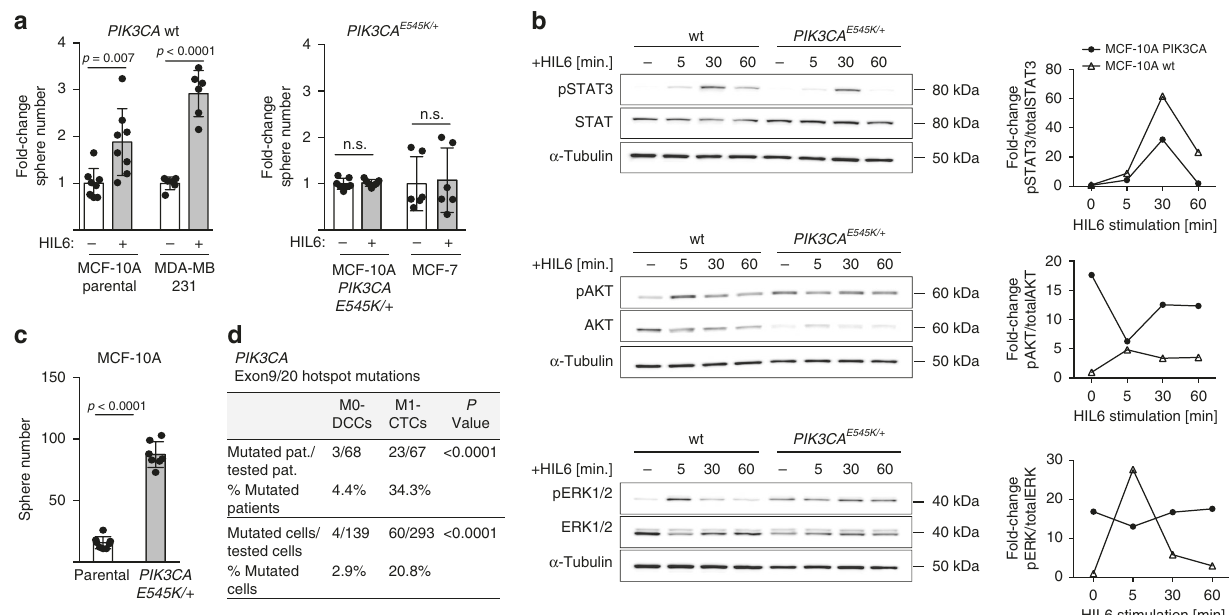
Fig. 7 PIK3CA pathway activation confers independency from IL6 signaling. a Fold change in sphere numbers of pre-malignant (MCF 10A) and tumorigenic cell lines (MCF-7, MDA-MB-231) without (MCF 10A parental, n = 8; MDA-MB-231, n = 6) or with mutational activation of PIK3CA (MCF 10A PIK3CAE545K/ + , n = 7; MCF-7, n = 6) cultured in the presence or absence of HIL6. Note that MCF 10A PIK3CAE545K/ + cells are isogenic to MCF 10A parental; n.s. = non-signi fi cant. b Western blot analyses showing phosphorylation of STAT3Tyr705, AKTSer475 and ERK1/2Thr202/Tyr204 in MCF 10A or MCF 10A PIK3CAE545K/ + cells cultured without or with HIL6 for the indicated time. For quanti fi cation, the signal of the phosphorylated protein and total protein was normalized to α -tubulin, then the ratio of phosphorylated to total protein was calculated. The graphs show the fold change in signal ratio over time relative to the control (unstimulated MCF 10A wt = 1). c Sphere numbers of the isogenic cells MCF 10A parental ( n = 8) and MCF 10A PIK3CAE545K/ + ( n = 7) cultured in the absence of HIL6. d Cytokeratin 8/18/19 + DCCs from BM of non-metastasized (M0-stage) HR-positive breast cancer patients and CD45-/EpCAM + /cytokeratin 8/18/19 + CTCs isolated from peripheral blood of metastasized (M1-stage) HR-positive breast cancer patients were sequenced for hotspot-mutations in PIK3CA (Exon 9: E545K, E542K; Exon 20: H1047R, H1047L, M1043I). P values in a , c two-sided Student ’ s test; d two-sided Fisher ’ s exact test. All error bars correspond to standard deviation (Mean ±